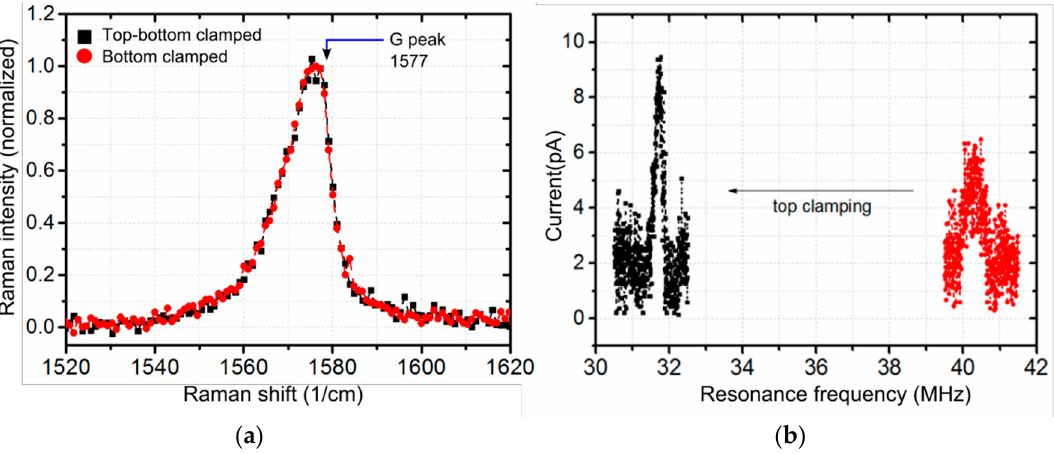
Figure 2. ( a ) Raman spectra of the suspended nanotube measured for two different clamping geometries; ( b ) Resonance frequency downshift from 40.2 MHz to 31.5 MHz after top